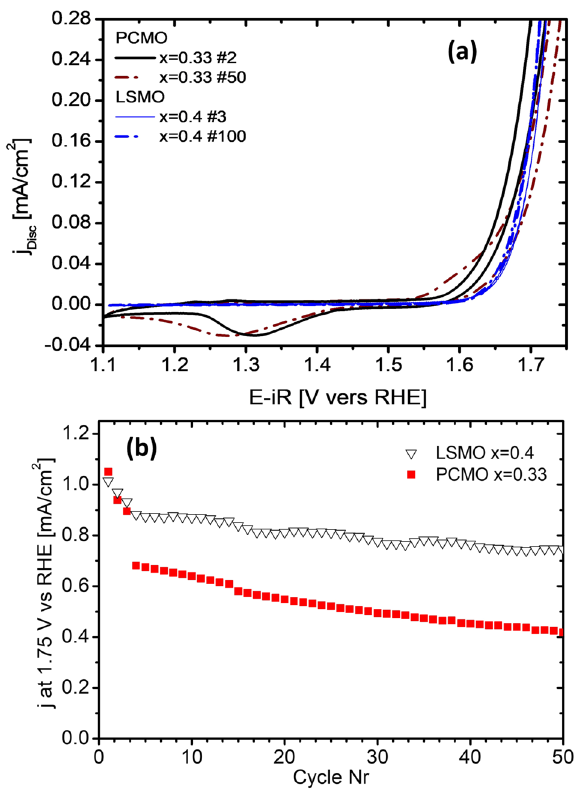
Fig. 1 Electrocatalytic characterization. a Cyclovoltammetry of (001) oriented epitaxial thin fi lm manganite electrodes in 0.1 M aqueous KOH solution at 10 mV/s and rotated at 1600 rpm for cycles #2/#50 (PCMO) and #3/#100 (LSMO), respectively. In addition to the OER, PCMO shows a pronounced surface redox couple. b Temporal stability of the electrode current density at E = 1.75 V vers. RHE for cycling from E = 1.1 – 1.75 V vers. RHE and 7 min chronoamperometric OER between cycle 3 and 4 (see method